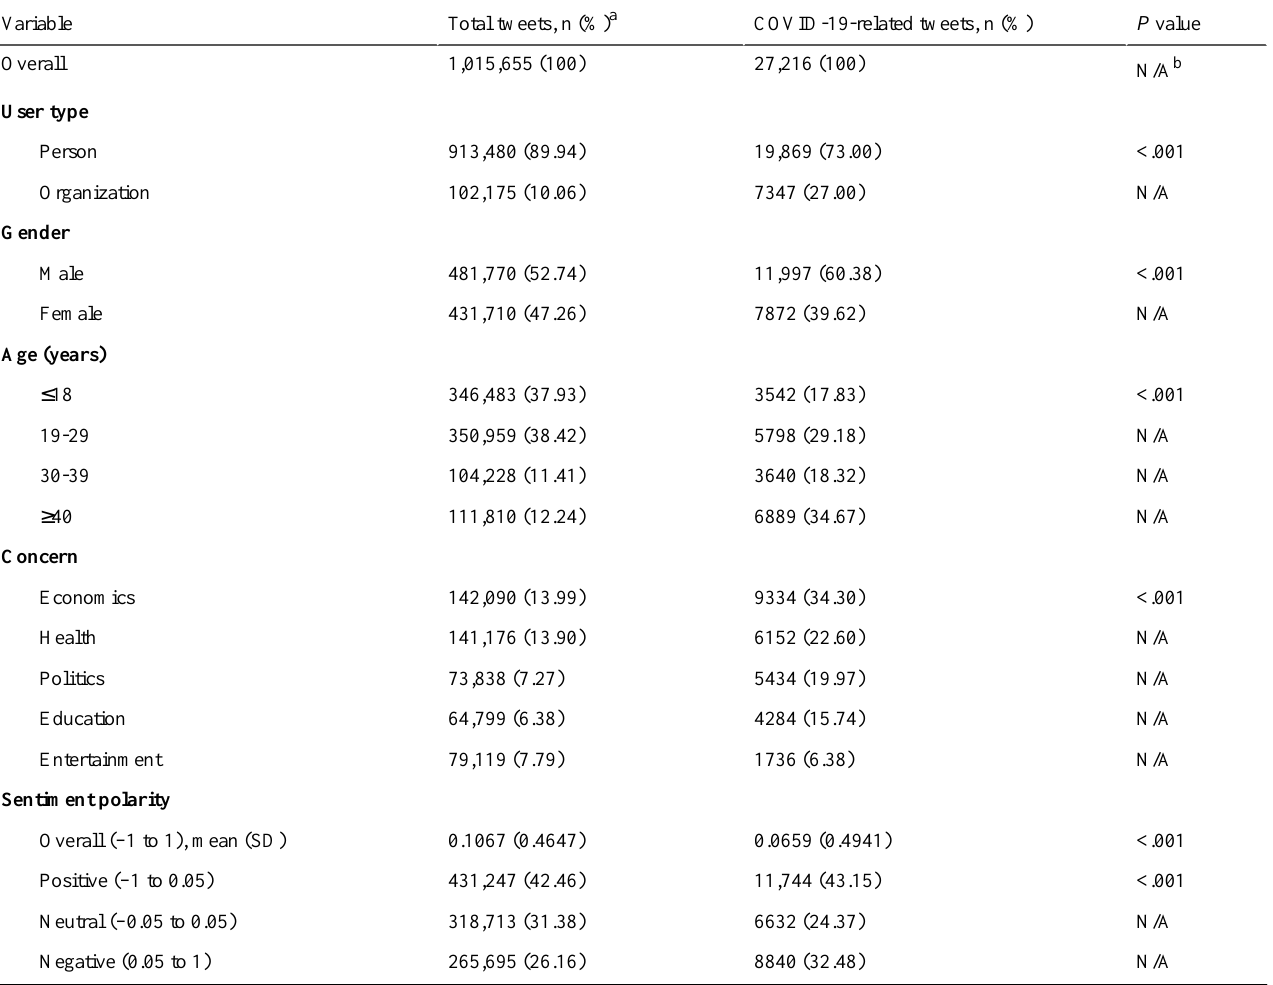
Table 3. Statistical distributions of the emulated questionnaire